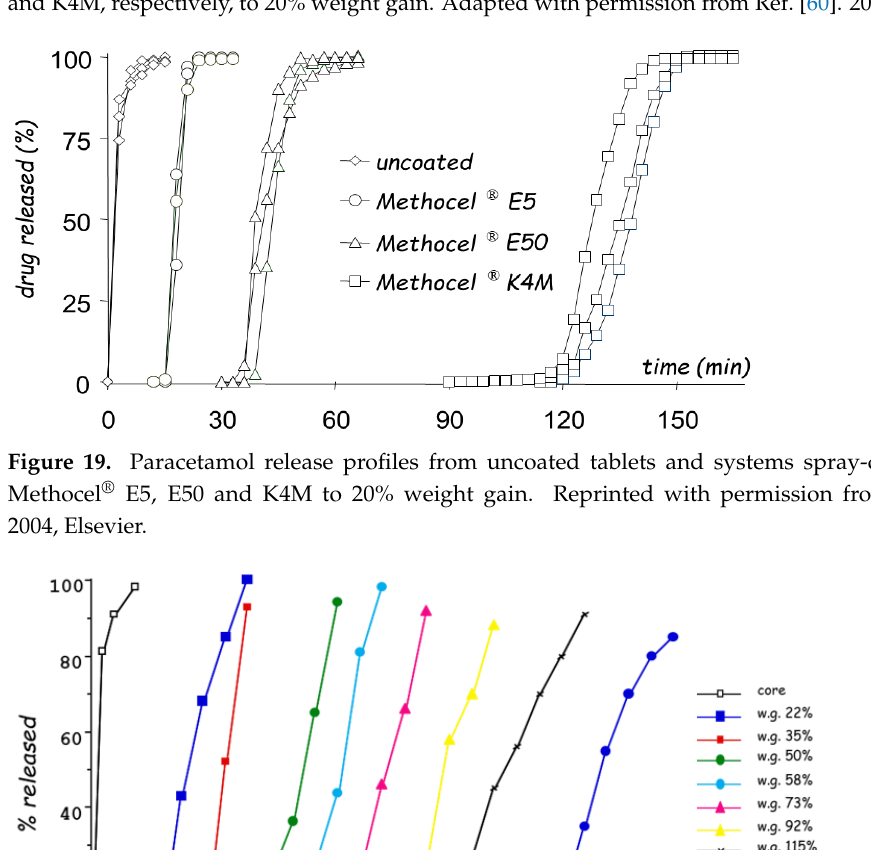
Figure 21. Mean salivary antipyrine concentration profiles after oral administration of uncoated cores (A) and systems coated with Methocel ® E50 up to 50% (B) and 100% (C) weight gains. Adapted with permission from Ref. [61]. 2001, Elsevier.